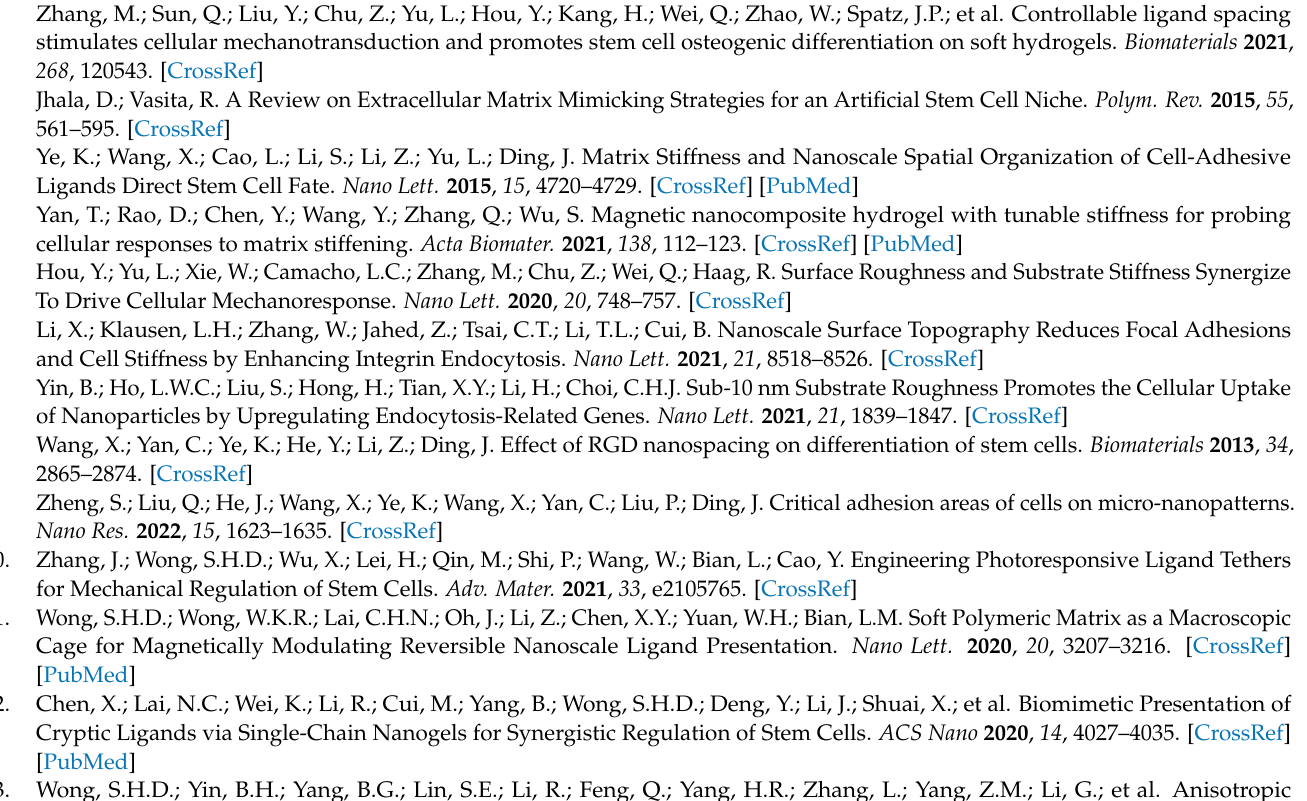
NMR spectrum of MeHA polymers, Figure S3: DLS data of as-prepared and functionalized SiO 2 NPs. Figure S4: Exploration of immobilized SiO 2 NPs in MeHA hydrogel network. Figure S5: Evaluation of cell spreading of cells cultured on a glass substrate. Figure S6: Examination of the expression level of ALP and RUNX2 in undifferentiated